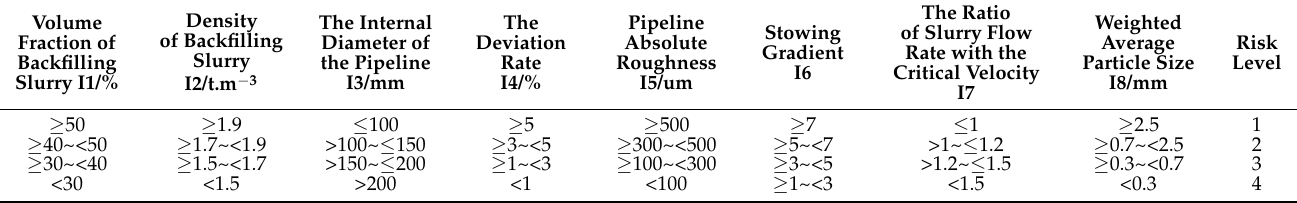
Table 1. The assessment criteria for the failure risk level of the backfilling pipeline.